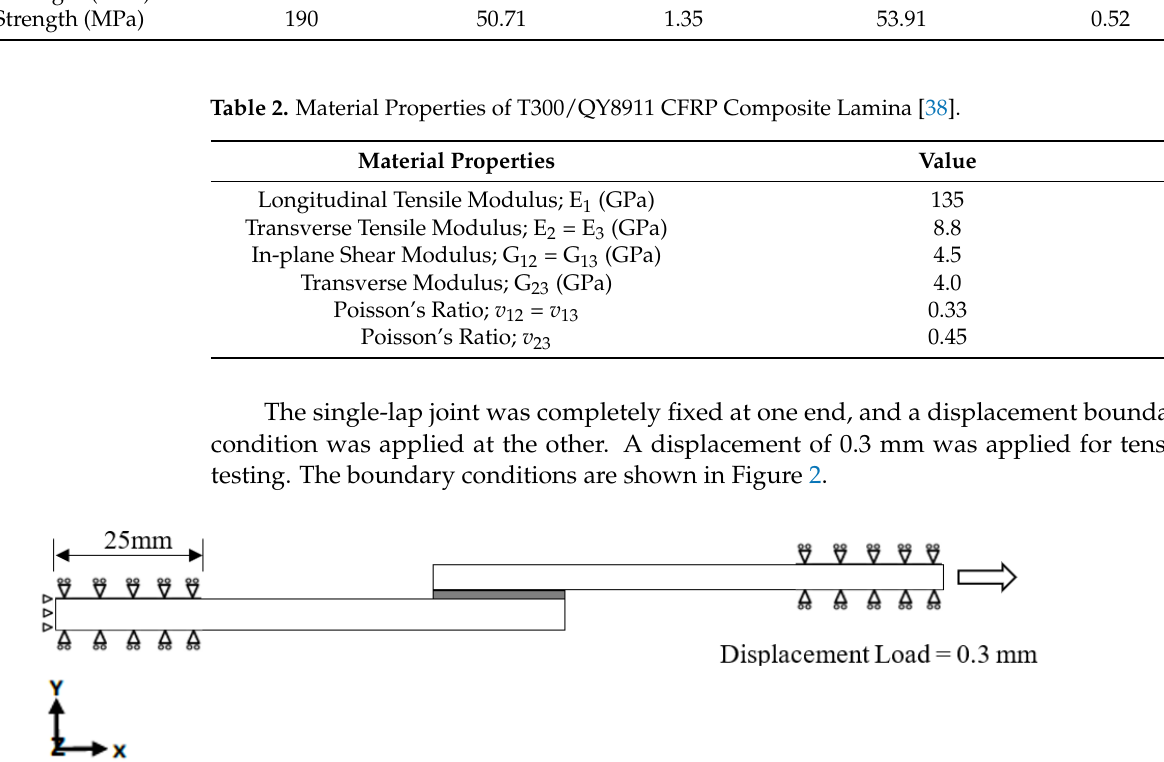
Table 2. Material Properties of T300/QY8911 CFRP Composite Lamina [38] .